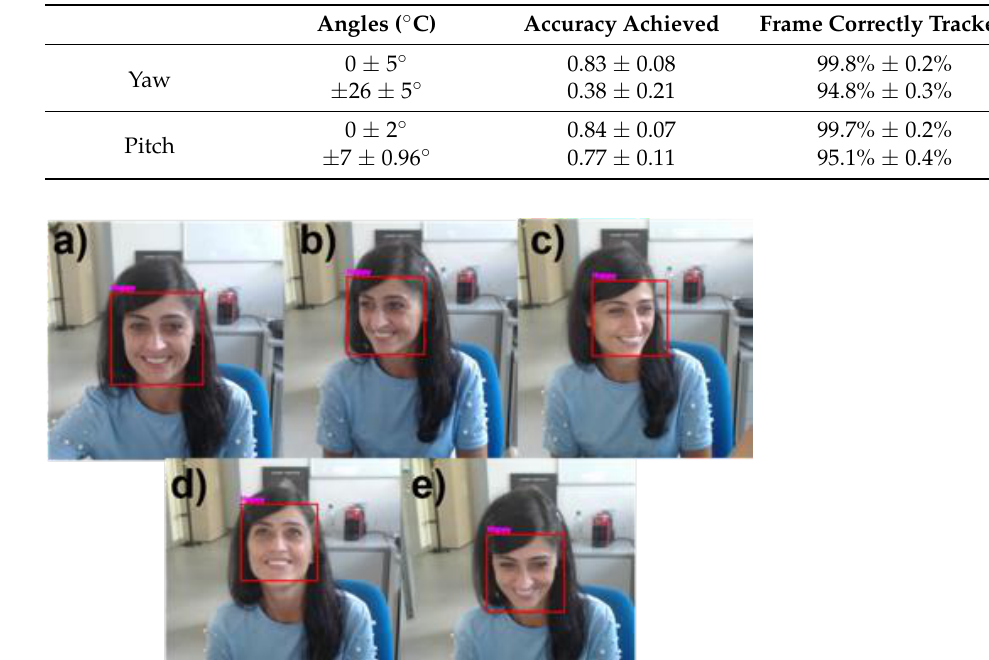
Table 2. Percentage of frames where the face was correctly detected and the accuracy achieved with respect to different facial orientation angles.